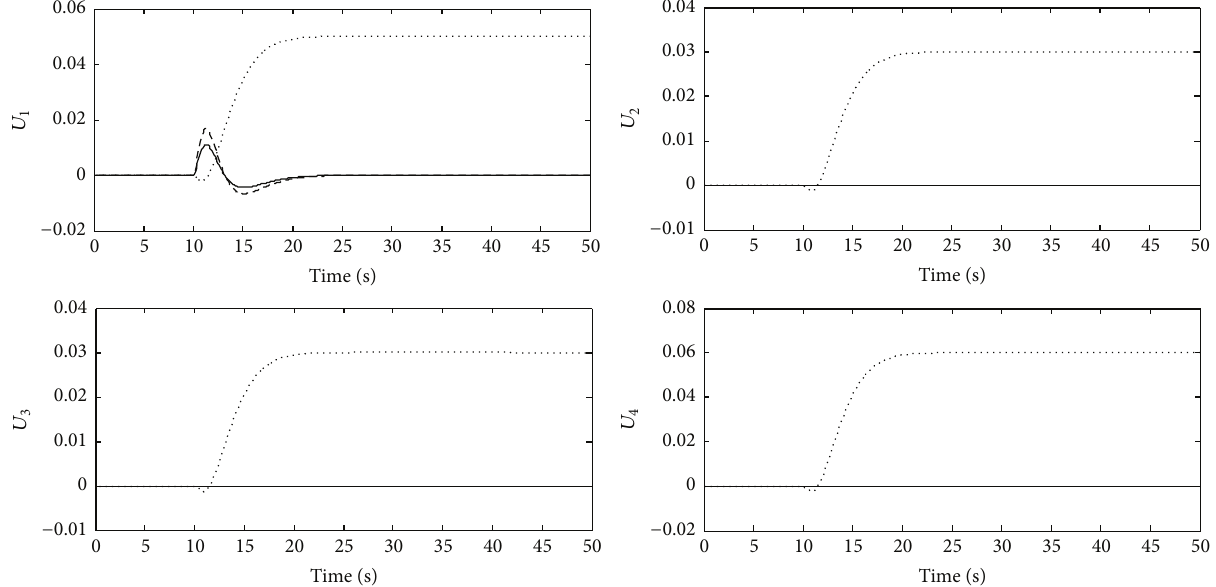
Figure 14: Control signal of distributed MPC in Case 2: Δ𝜃